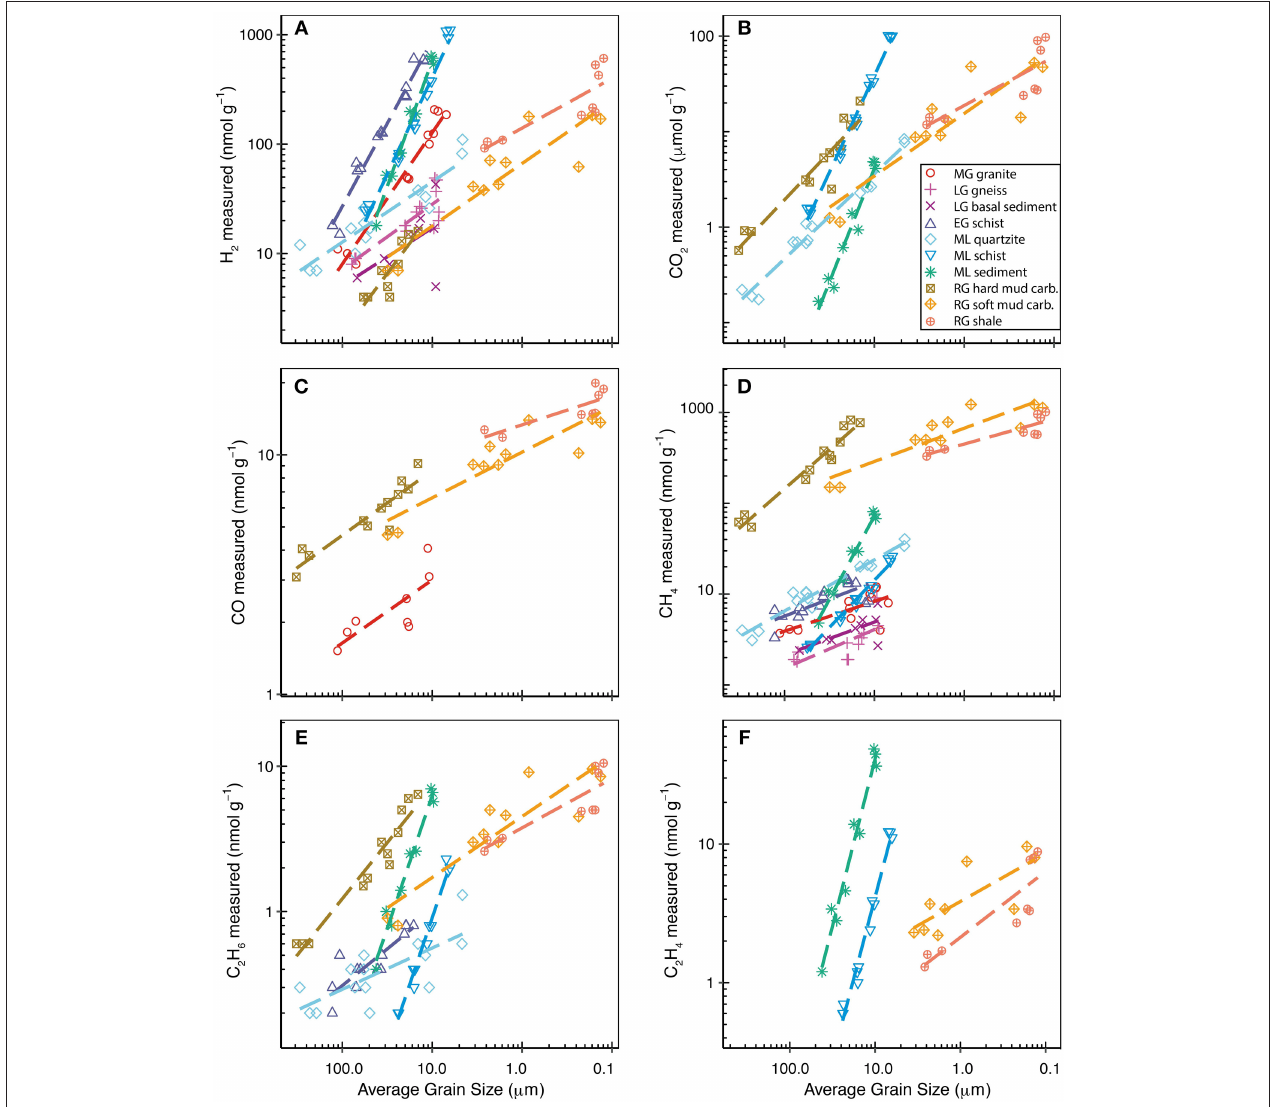
FIGURE 1 | H 2 (A), CO (C) , CH 4 (D) , C 2 H 6 (E) , C 2 H 4 (F) produced in nmol g − 1 , and CO 2 (B) produced in µ mol g − 1 when grinding the rock and sediment samples to different average grain sizes. Grain size decreases and grinding time increases from left to right. Dashed lines are the power relationship between grain size and the respective gas for each sample (which is linear in log-log